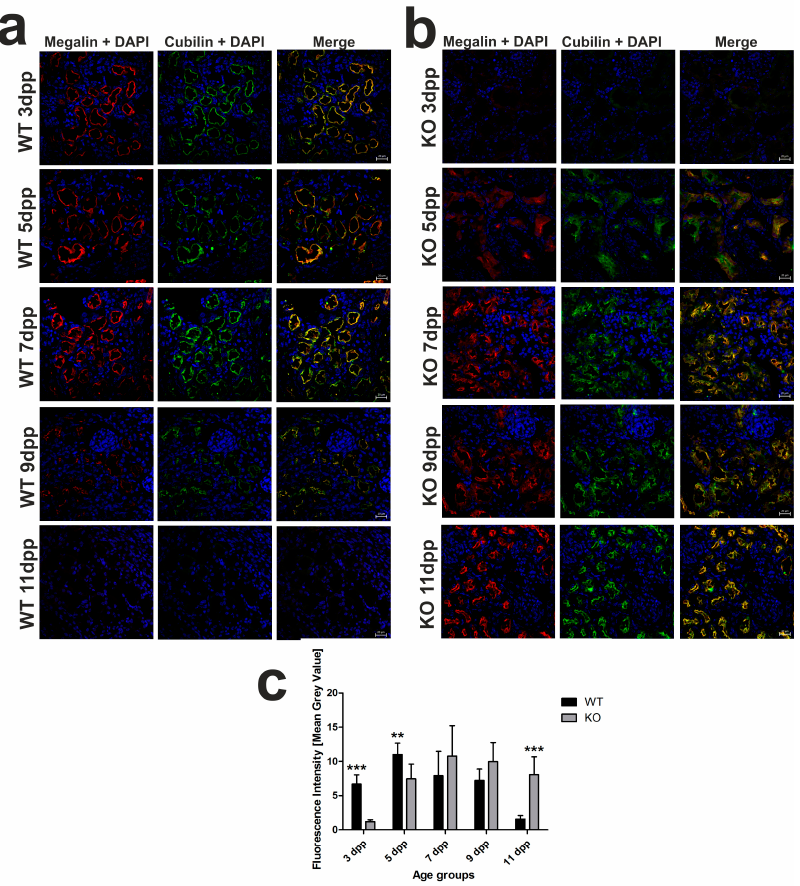
Figure 3. Localization of megalin–cubilin complex in renal proximal tubules in wild-type (WT) and heme oxygenase 1 (HO1) knockout (KO) neonatal mice. ( a ) Immunofluorescence (IF) staining of megalin (red channel) and cubilin (green channel) in the kidneys of the 3, 5, 7, 9, and 11 day old WT mice, analyzed by confocal microscopy. Both transporters have apical localization in the epithelial cells of cortical renal tubules. Cell nuclei were counterstained with DAPI (blue). Scale bars correspond to 20 µm. ( b ) IF staining of megalin (red channel) and cubilin (green channel) in the kidneys of the 3, 5, 7, 9, and 11 day old KO mice, analyzed by confocal microscopy. Both transporters are absent from epithelial cells of cortical renal tubules in 3 day old knockout mice; in 5 day old mice, they exhibit cytoplasmic localization, and, starting from day 7, both transporters have apical localization in the cells. Cell nuclei were counterstained with DAPI (blue). Scale bars correspond to 20 µm. ( c ) Quantitative analysis of co-localized fluorescent signal from megalin–cubilin complex in renal cortical tubules. The mean fluorescence signal associated with megalin and cubilin was measured on the whole renal cortex by ImageJ analysis and quantified manually as a mean gray value; the intensities (means ± SD) are plotted in arbitrary units (AU); n = 10 for WT 3 dpp, n = 9 for WT 5 dpp, n = 11 for WT 7 dpp, n = 8 for WT 9 dpp, n = 13 for WT 11 dpp, n = 6 for KO 3 dpp, n = 8 for KO 5 dpp, n = 14 for KO 7 dpp, n = 5 for KO 9 dpp, and n = 9 for KO 11 dpp. To compare differences in mean gray value (fluorescence intensity) between WT and Hmox1 KO groups at each time point, Student t- tests were used in 3 dpp and 11 dpp groups, and Mann–Whitney U tests were used in 5 dpp, 7 dpp, and 9 dpp groups. ** p < 0.01, *** p < 0.001. dpp—days postpartum.